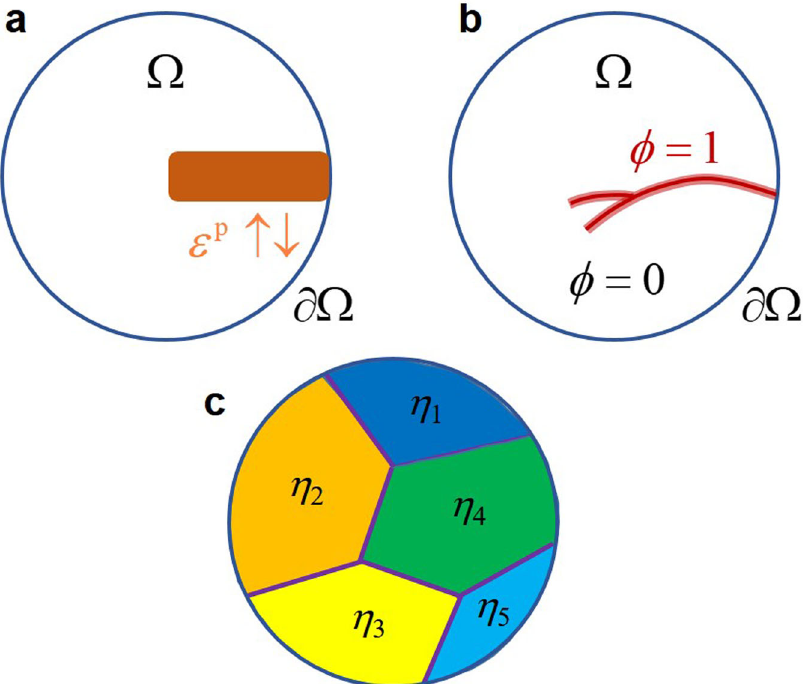
Fig. 1 Schematics for the order parameters considered in this work. a – c Schematic distributions of plastic strain, cracks, and grains,